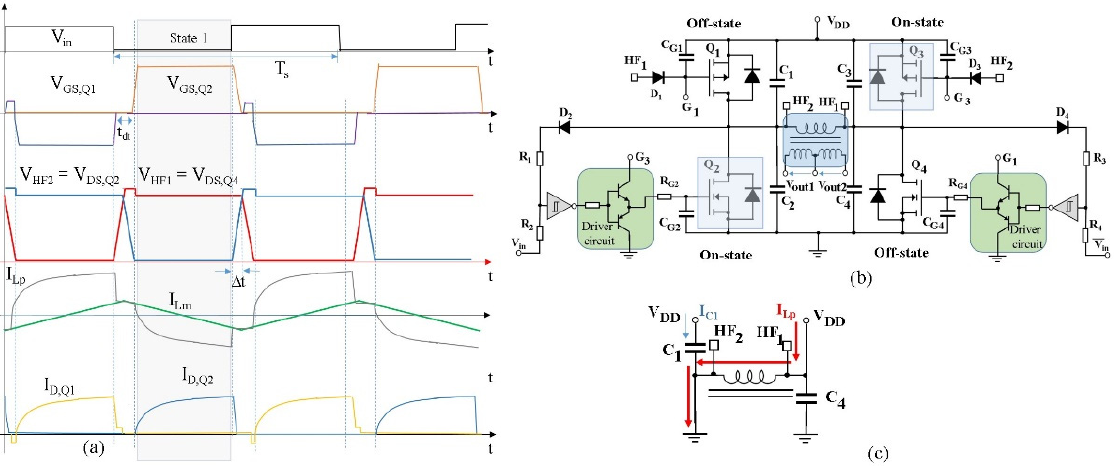
Figure 7. ( a ) Qualitative switching waveforms at starting of the description (State 1). ( b ) Switching conditions of the MOSFETs. ( c ) Primary side of the HF transformer and capacitors’ interactions. In the second phase, the first voltage transition occurs. V in rises high, while V in inverted, applied to the Q 4 driver circuit is 0. In the initial state, V HF 1 was high. The